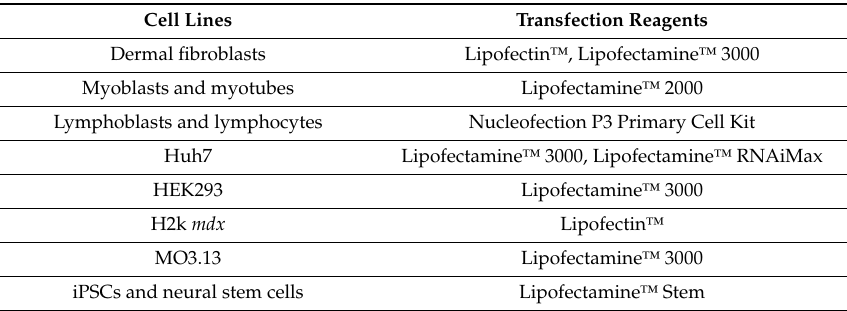
Table 1. Recommended transfection reagents for di ff erent cell